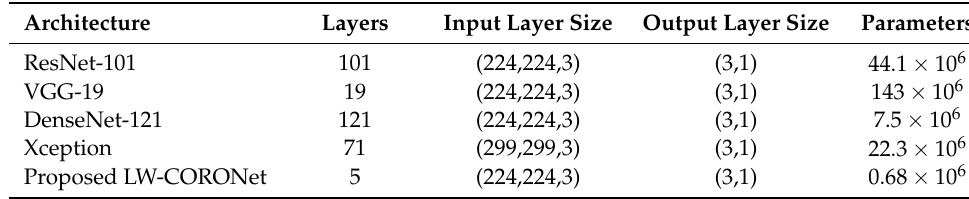
Table 3. Architectural details of pre-trained CNN